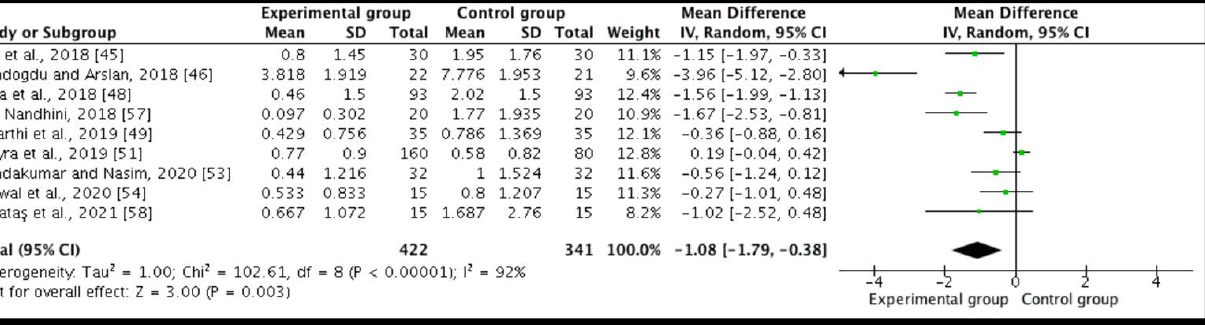
Figure 4. Forest plot comparing postoperative pain between the experimental group (intracanal cryotherapy) and the control group (room temperature) at 24 h.